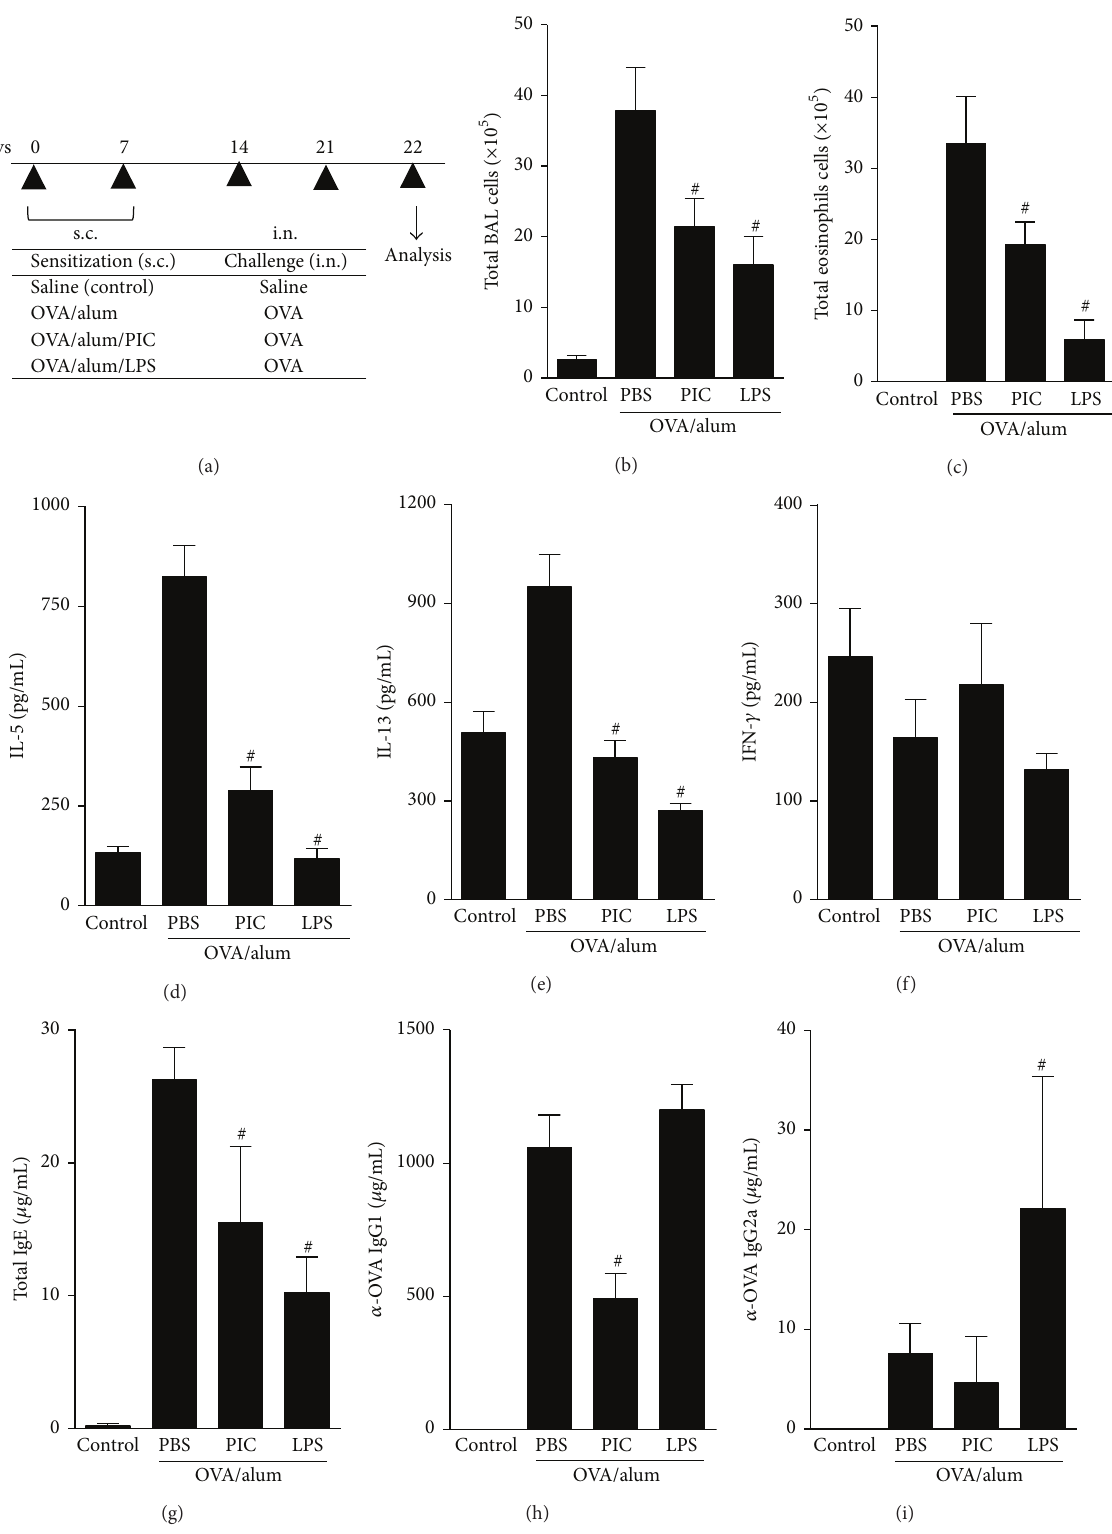
Figure 1: Effects of adsorption of PIC (TLR3) or LPS (TLR4) agonists onto OVA/alum sensitization on OVA-induced cellular and humoral responses. (a) Protocol: C57BL/6 WT mice sensitized with s.c. OVA/alum in the presence or not of PIC (10 𝜇 g) or LPS (10 𝜇 g) on days 0 and 7 and challenged with OVA i.n. on days 14 and 21. Samples obtained on day 22. (b) Total number of cells and (c) eosinophils in BAL; ((d), (e), and (f)) levels of IL-5, IL-13, and IFN- g in BAL. ((g), (h), and (i)) Levels of serum isotypes: total IgE, OVA-specific IgG1, and OVA-specific IgG2a. Data shown as mean ± SE, one-way ANOVA: # 𝑃 < 0.05 different from OVA/alum/PBS group ( 𝑛 = 5 ), and experiment was repeated